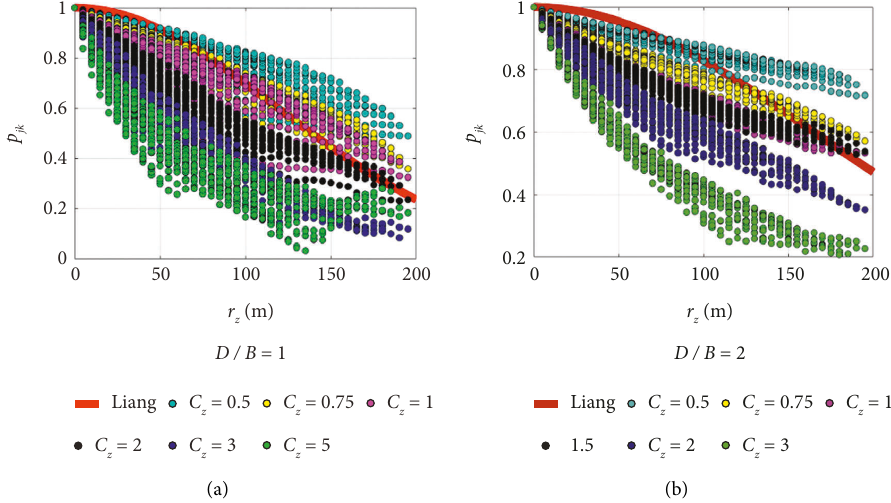
Figure 3: Vertical correlation for across-wind forces: B/H =